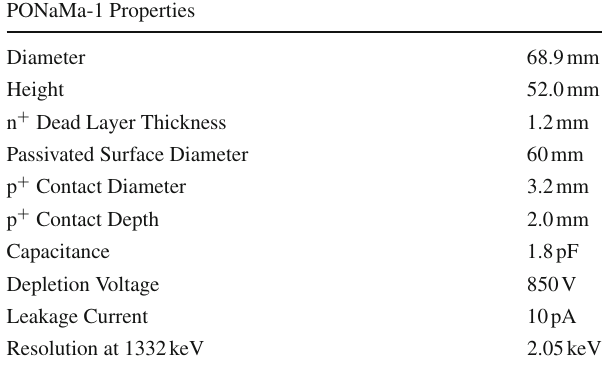
Table 1 Dimensions and operating parameters of the PONaMa-1 PPC detector.Thedimensionsweredeterminedbythedetectormanufacturer. The n + dead layer thickness, capacitance, depletion voltage, leakage current, and resolution were determined by the detector manufacturer and then confirmed with independent measurements conducted as part of the Majorana Demonstrator detector characterization campaign